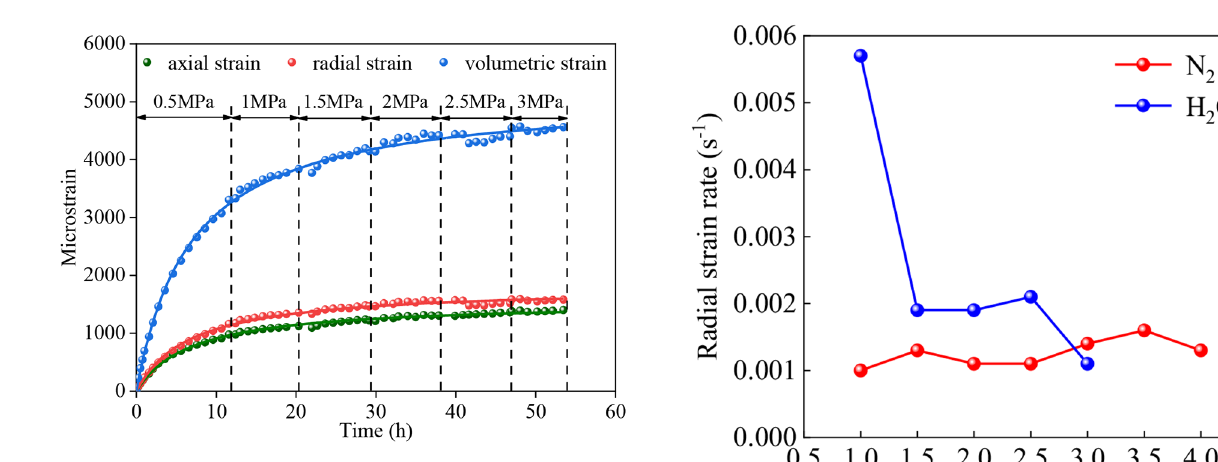
Fig. 3 Microstrain versus time during water